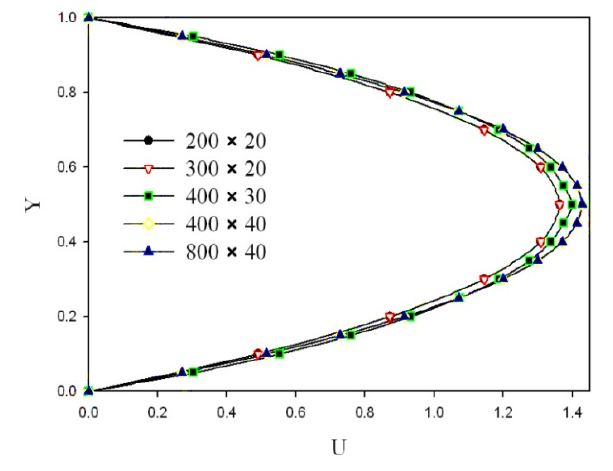
Table 2. Comparison of total Nusselt number for